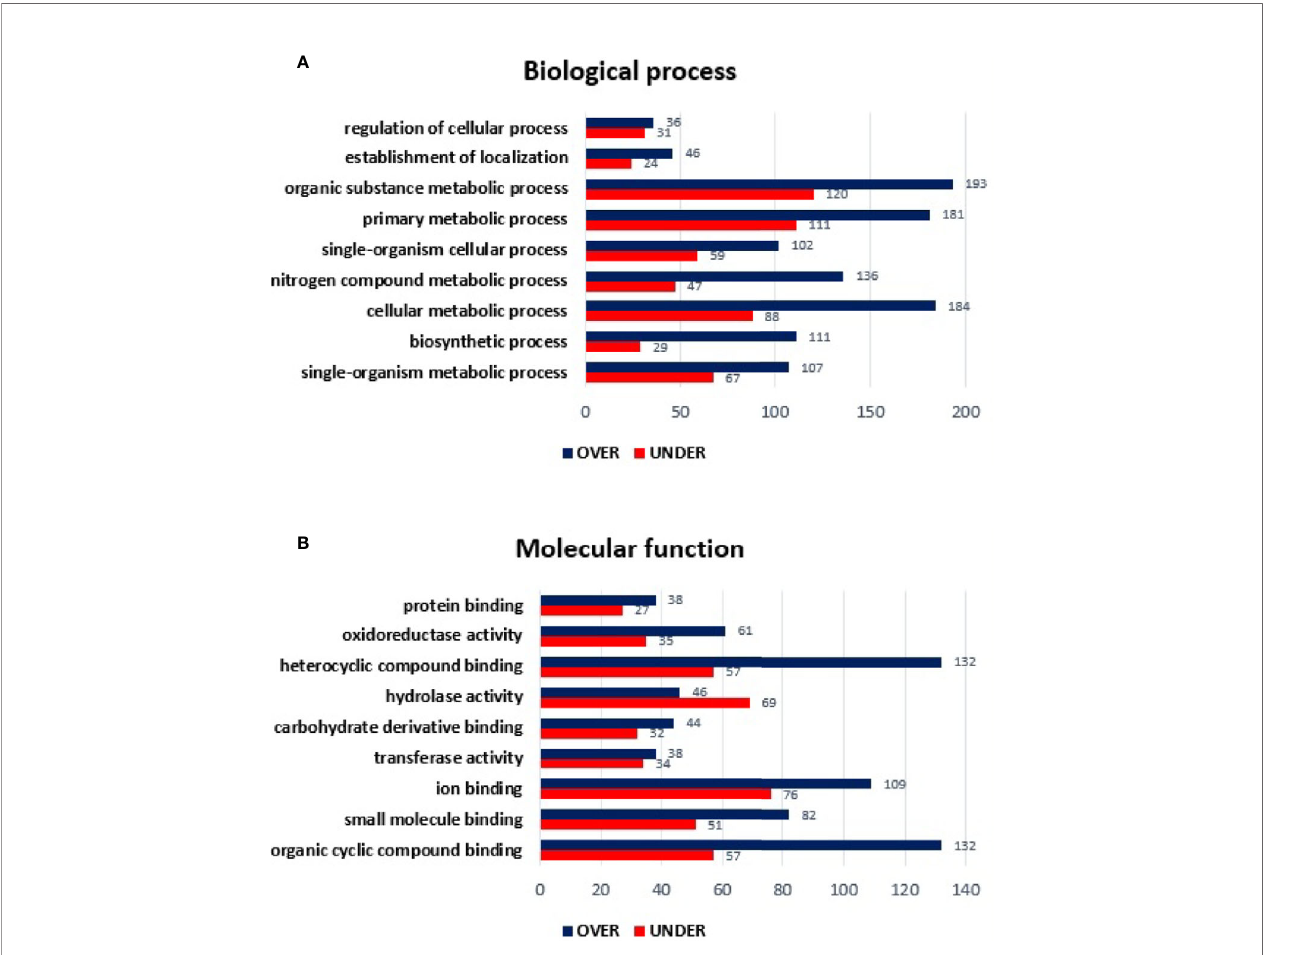
FIGURE 5 | Gene ontology of differentially represented proteins from midgut of R. sanguineus tropical lineage vs. R. sanguineus temperate lineage in the infection condition. GO terms and its representation of biological process (A) , and molecular function (B) obtained using level 3. Blue bars represent the number of over- represented proteins in the tropical lineage compared to the temperate lineage and red bars represented the number of under-represented proteins in the tropical lineage compared to the temperate lineage (can be interpreted as the number of proteins more represented in the temperate lineage compared to the tropical lineage), with statistical signi fi cance ( p <